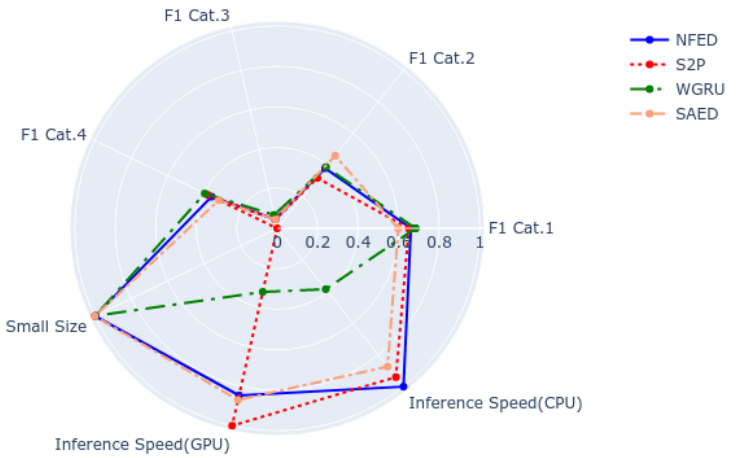
Figure A2. Diagram that summarizes the capabilities of the models to disaggregate a fridge.